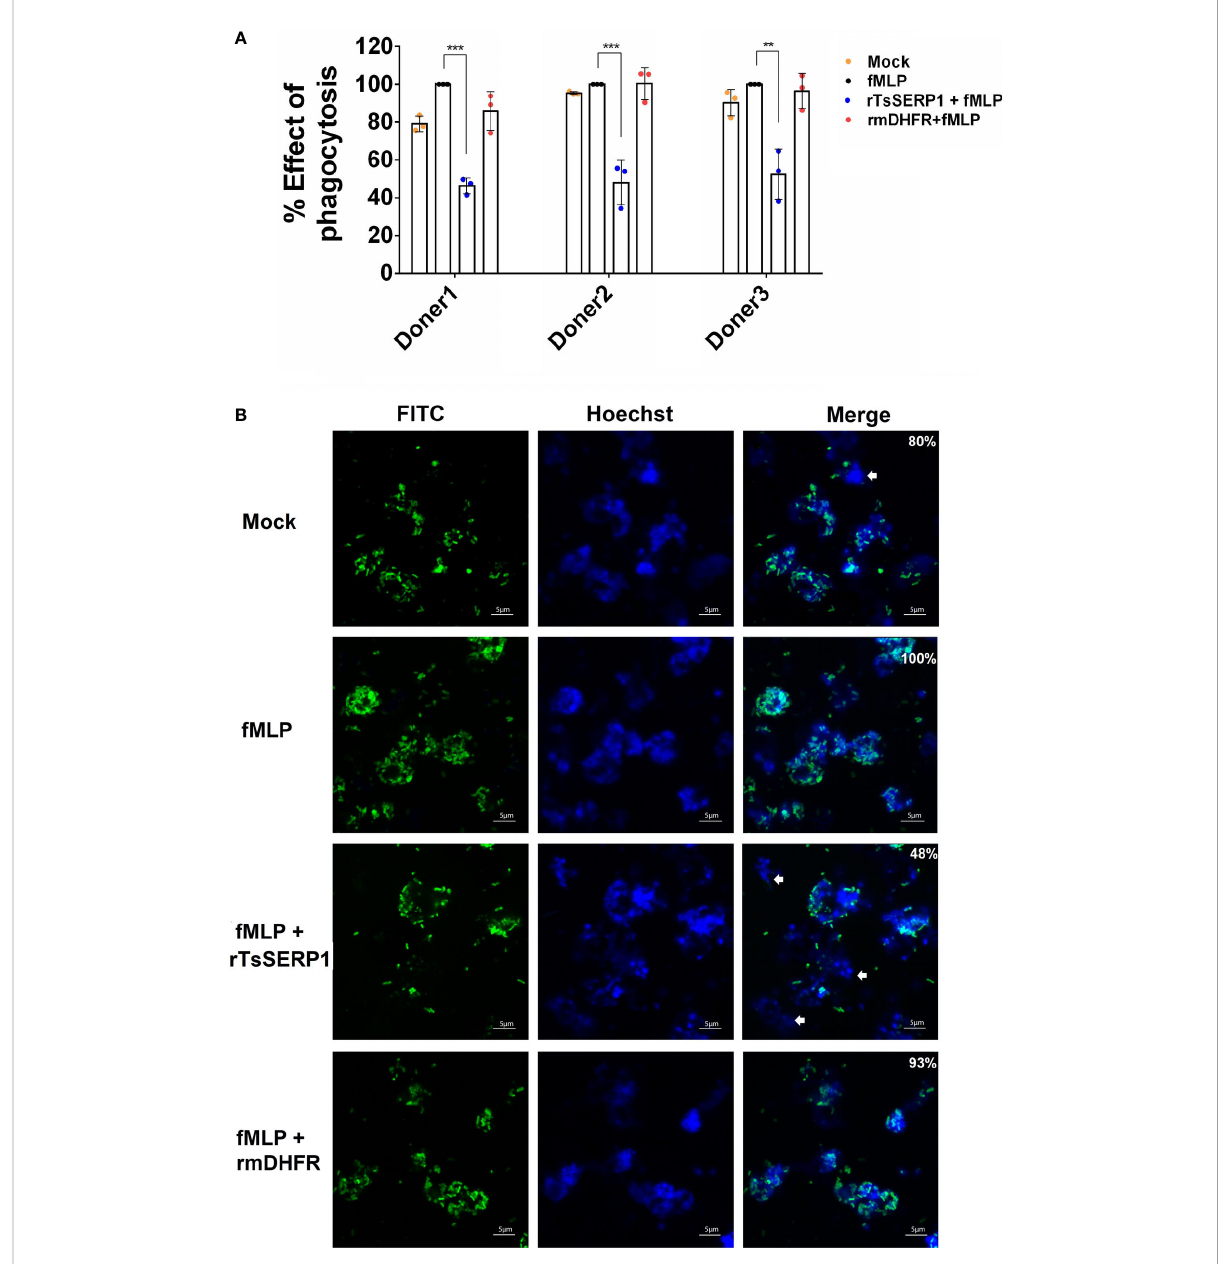
FIGURE 3 rTsSERP1 impairs neutrophil phagocytosis. The phagocytosis of neutrophils was induced by 100 nM of fMLP prior to treatment with 10 µg/ml of rTsSERP1 or an irrelevant control (rmDHFR), followed by incubation with the fl uorescent E. coli BioParticle. After incubation, the fl uorescent signal was measured and subsequently calculated as the percentage of phagocytosis (A) . Neutrophils treated with fMLP alone were set as 100% phagocytotic effect. The bar charts show the data of three different donors, which are presented as the mean ± SD. The experiments were performed in triplicate with three independent experiments. One-way ANOVA followed by a Bonferroni multiple comparison test were used for statistical analysis: ** p < 0.01 and *** p < 0.001. Fluorescent images (B) were captured to con fi rm the above result. The percentage of phagocytosis positive out of the total number of alive neutrophils was indicated in the merge of picture. The E. coli BioParticle was labeled with FITC (green) and the nucleus was counterstained with Hoechst 33342 (blue). Examples of non-phagocytotic neutrophils are indicated by white arrows. The treatment conditions were included media alone (Mock), only fMLP induction (fMLP), fMLP induction and rTsSERP1 treatment (rTsSERP1+fMLP), fMLP induction and irrelevant control (rmDHFR) treatment